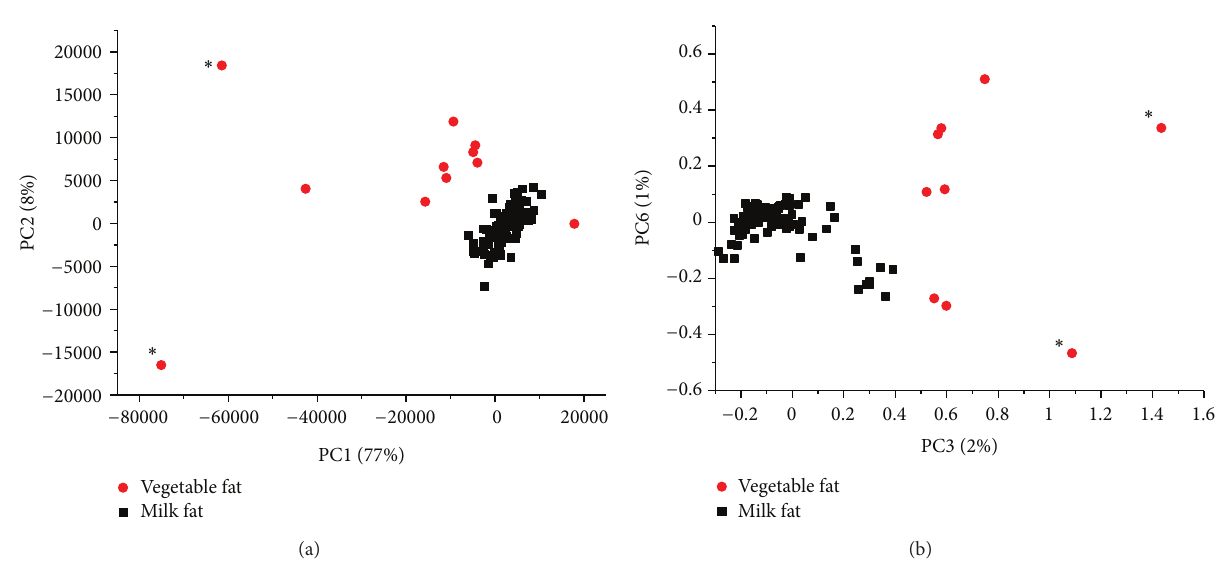
Figure 3: Scatter plot of the PCA scores for 1 H NMR ((a), 3.0–0.25 ppm) and 13 C NMR ((b), 200–0.25 ppm) for cheese samples (stars denote tzatziki